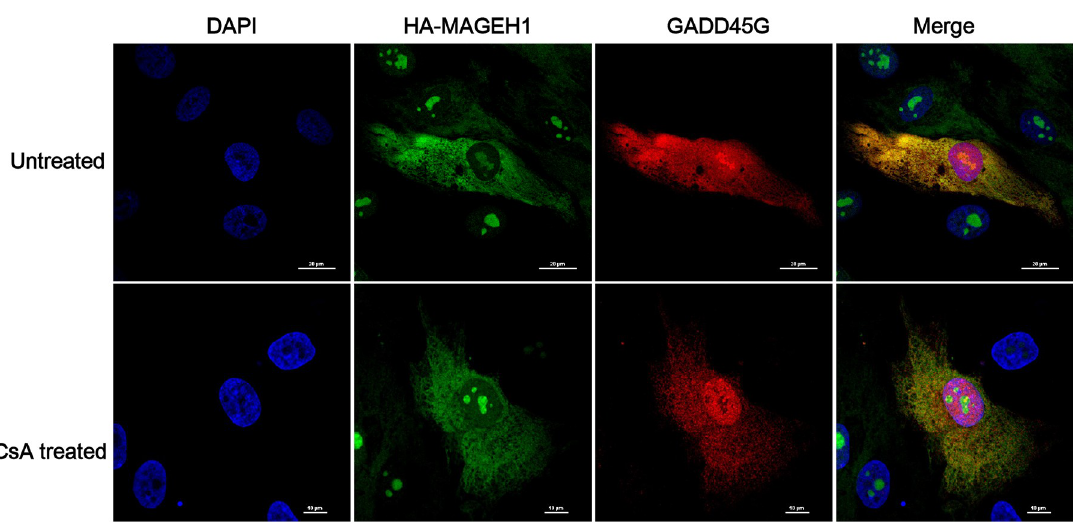
Fig 3. Confocal laser scanning immunofluorescence analysis to detect the interaction between GADD45G and MAGEH1. HRE cells were infected with Ad-GADD45G and Ad-HA-MAGEH1 simultaneously at an MOI of 250 for 24 hours. At the same time, HRE cells were not treated or treated with 25 μ g/ml CsA for 24 hours and then subjected to immunofluorescent staining for the HA epitope (green) and GADD45G (red). In the merged image, yellow indicates costaining of the two proteins. DAPI staining (blue) was used to visualize the cell nucleus. The first row is showing cells not treated with CsA. The second row is showing cells treated with CsA. Scale bar: 10 μ m. https://doi.org/10.1371/journal.pone.0260135.g003 PLOS ONE | https://doi.org/10.1371/journal.pone.0260135 November17,